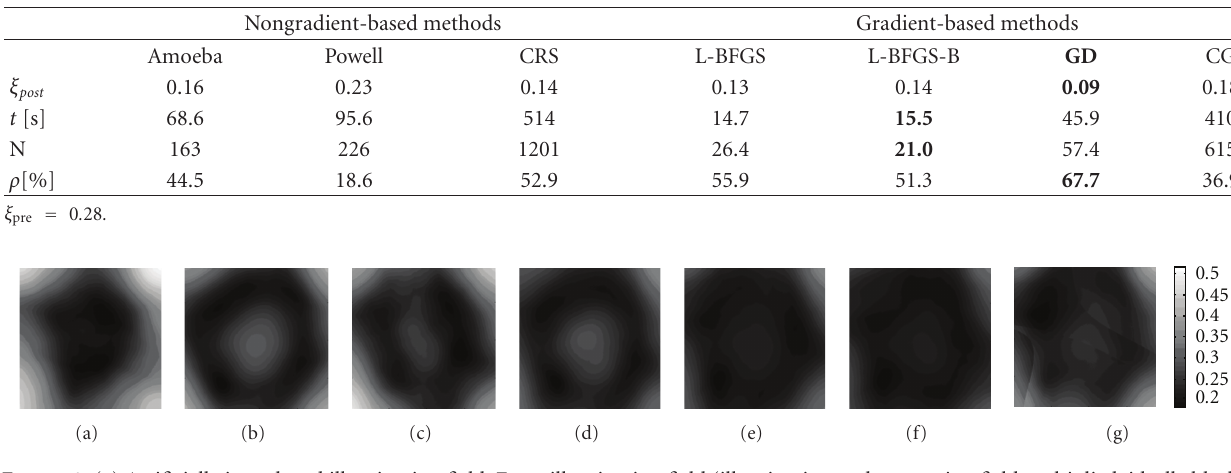
Figure 8: (a) Artificially introduced illumination field. Error illumination field (illumination and restoration field multiplied, ideally black) using: (b) Amoeba optimizer, (c) Powel optimizer, (d) CRS, (e) LBFGS optimizer, (f) Gradient descent optimizer (g) Conjugate gradient optimizer.